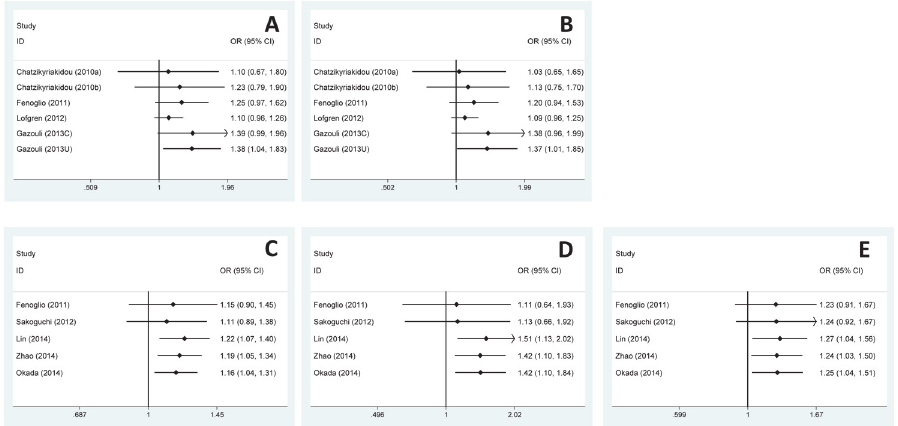
Fig 3. Cumulative meta-analysis of the association between rs2910164 and ADs risk. Every rhombus represents the pooled OR when studies accumulated over time, and the horizontal line represents the 95% CI of the pooled ORs. (A) Heterozygote model, GC vs GG, Caucasian subgroup, random model. (B) Dominant model, GC+CC vs GG, Caucasian subgroup, random model. (C) Allele model, C vs G, Other diseases subgroup, fixed model. (D) Homozygote model, CC vs GG, Other diseases subgroup, fixed model. (E) Dominant model, GC+CC vs GG, Other diseases subgroup, fixed model.